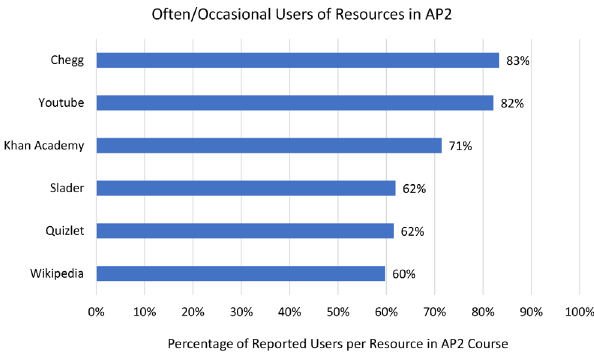
FIG. 12. Percentage of resource users who reported often or occasional usage frequency of that resource in Analytical Physics ¼ 151 ). 2 ( N AP 2